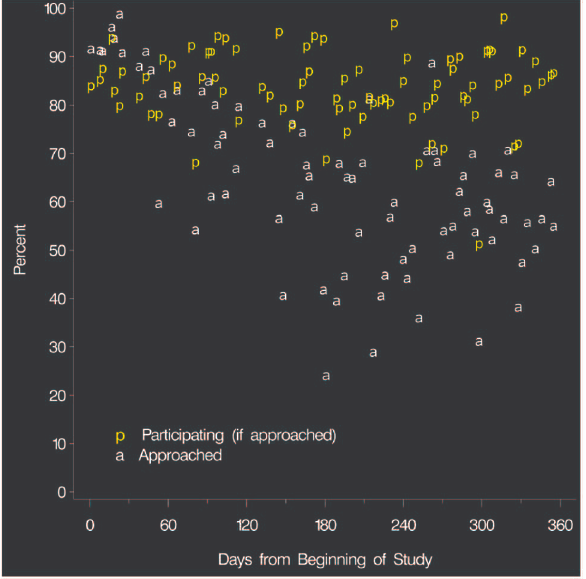
Figure 3. Participation rate and percent of patients ap- proached for each shift versus time, for the study